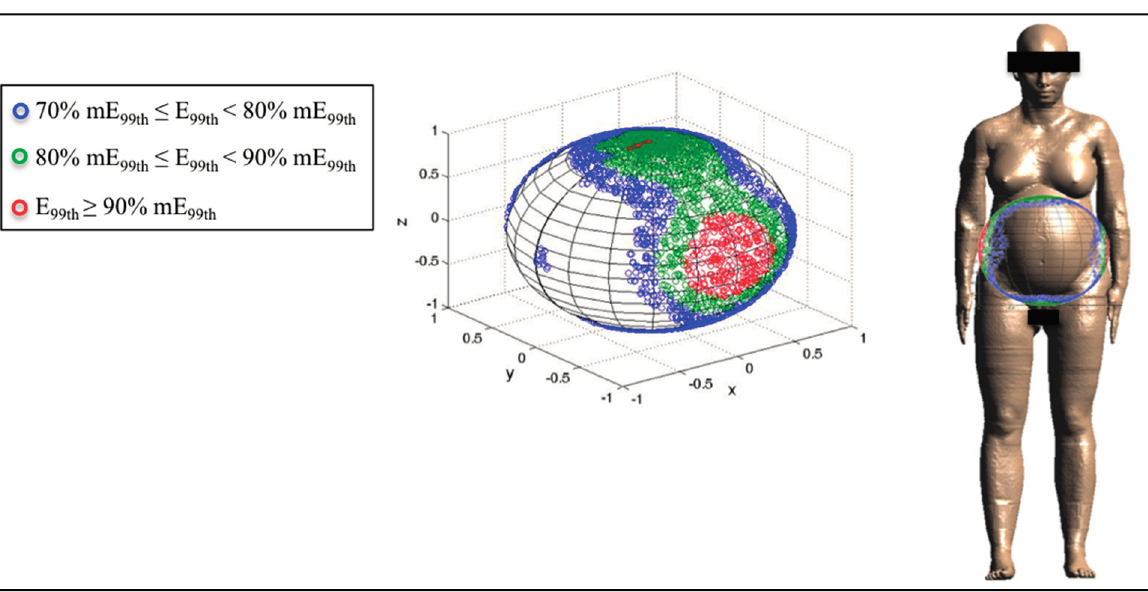
Figure 6. Distribution of B -field orientations on a unitary sphere represented in the pregnant woman’s reference system x,y,z (Figure 2), which determines, on the fetus whole-body at three months GA, induced electric field E 99th in the ranges 70% mE 99th to 80% mE 99th (blue circles), 80% mE 99th to 90% mE 99th (green circles) and higher than 90% mE 99th (red circles), respectively. These B orientations have been also indicated with respect to the reference system centered on the pregnant woman adopted in this study.